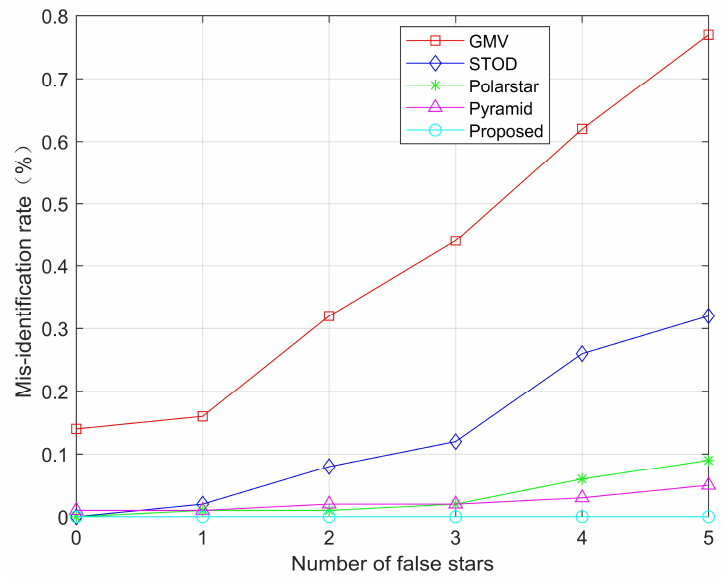
Figure 24. Misidentification rate benchmarking for sensitivity to false stars.